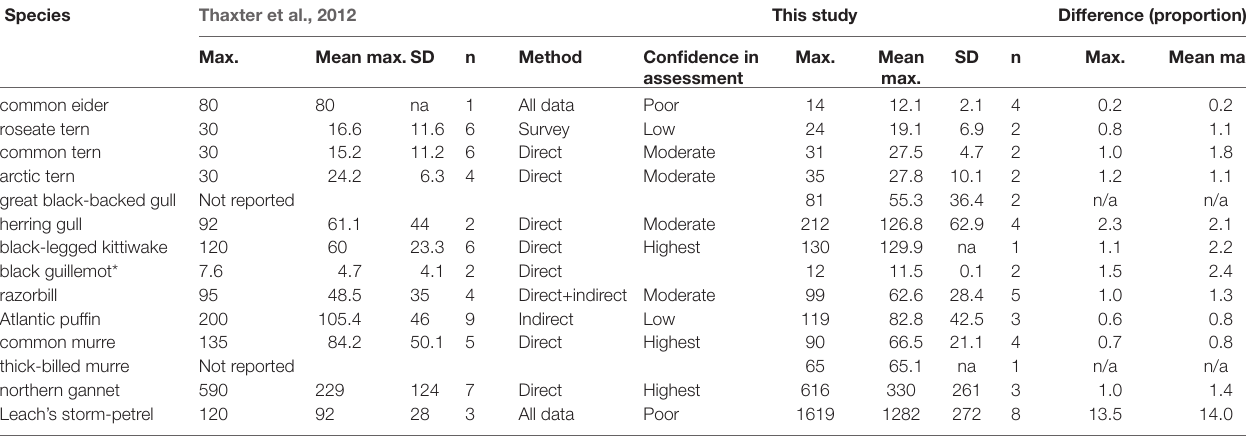
TABLE 6 | Summary of species-specific breeding season foraging ranges (km), comparing results of the current study against a comprehensive literature review (Thaxter et al., 2012). Species Thaxter et al., 2012 This study